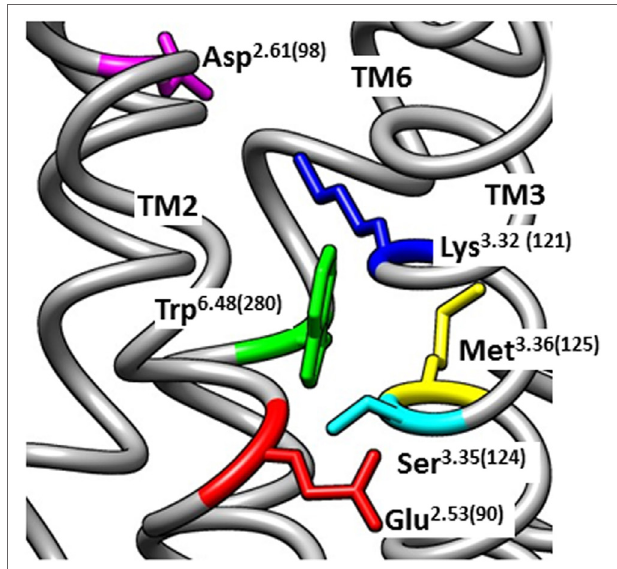
FiGURe 1 | Homology model of the inactive human gonadotropin-releasing hormone (GnRH) receptor. The model was downloaded from the GPCRdb website (www.gpcrdb.org/structure/homology_models) (71) and viewed using the UCSF Chimera software package (72) to show the spatial positioning of Glu 2.53(90) (red) relative to the neighboring residues Ser 3.35(124) (light blue), Lys 3.32(121) (dark blue), Asp 2.61(98) (magenta), Met 3.36(125) (yellow), and Trp 6.48(280) (green). Chimera is developed by the Resource for Biocomputing, Visualization, and Informatics at the University of California, San Francisco (supported by NIGMS